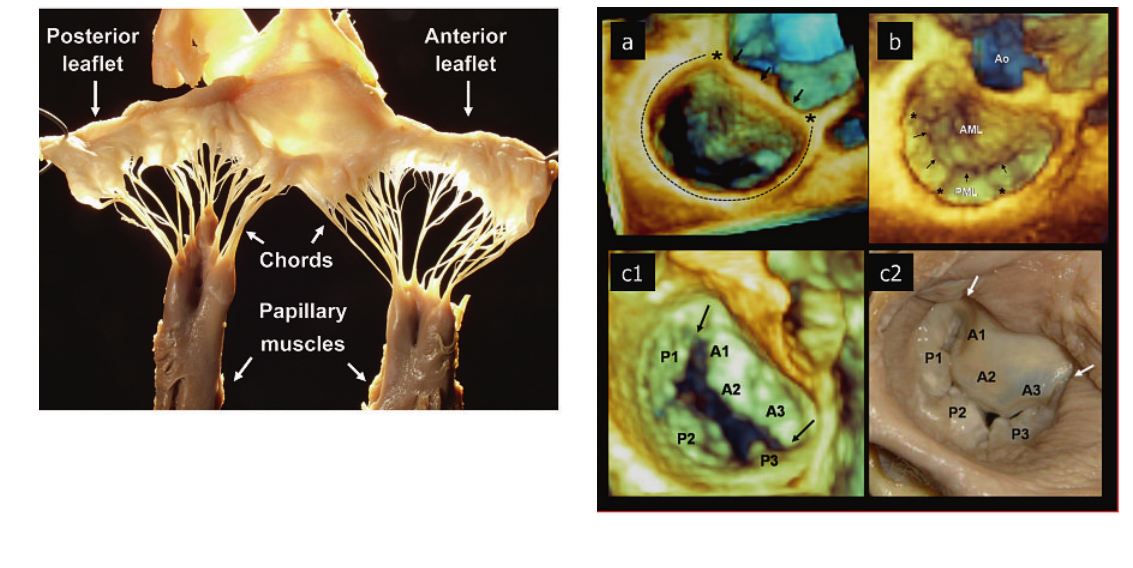
Real-time 3DTEE view of the mitral annulus and leaflets (atrial view); a) Mitral annulus (black arrows); b) Mitral valve; closed position (black arrows: line of coaptation between the two leaflets; asterisks: indentations between scallops). PML = posterior mitral leaflet; AML= anterior mitral leaflet; Ao = aorta; c1) Real-time 3DTEE image of mitral valve in mid-diastole; c2 corresponding anatomical specimen (atrial view). According to Carpentier, scallops of the posterior and anterior leaflets are labelled P1, P2, P3 (from lateral to medial) and A1, A2, A3, respectively (arrows: commissures at the extremities of the coaptation